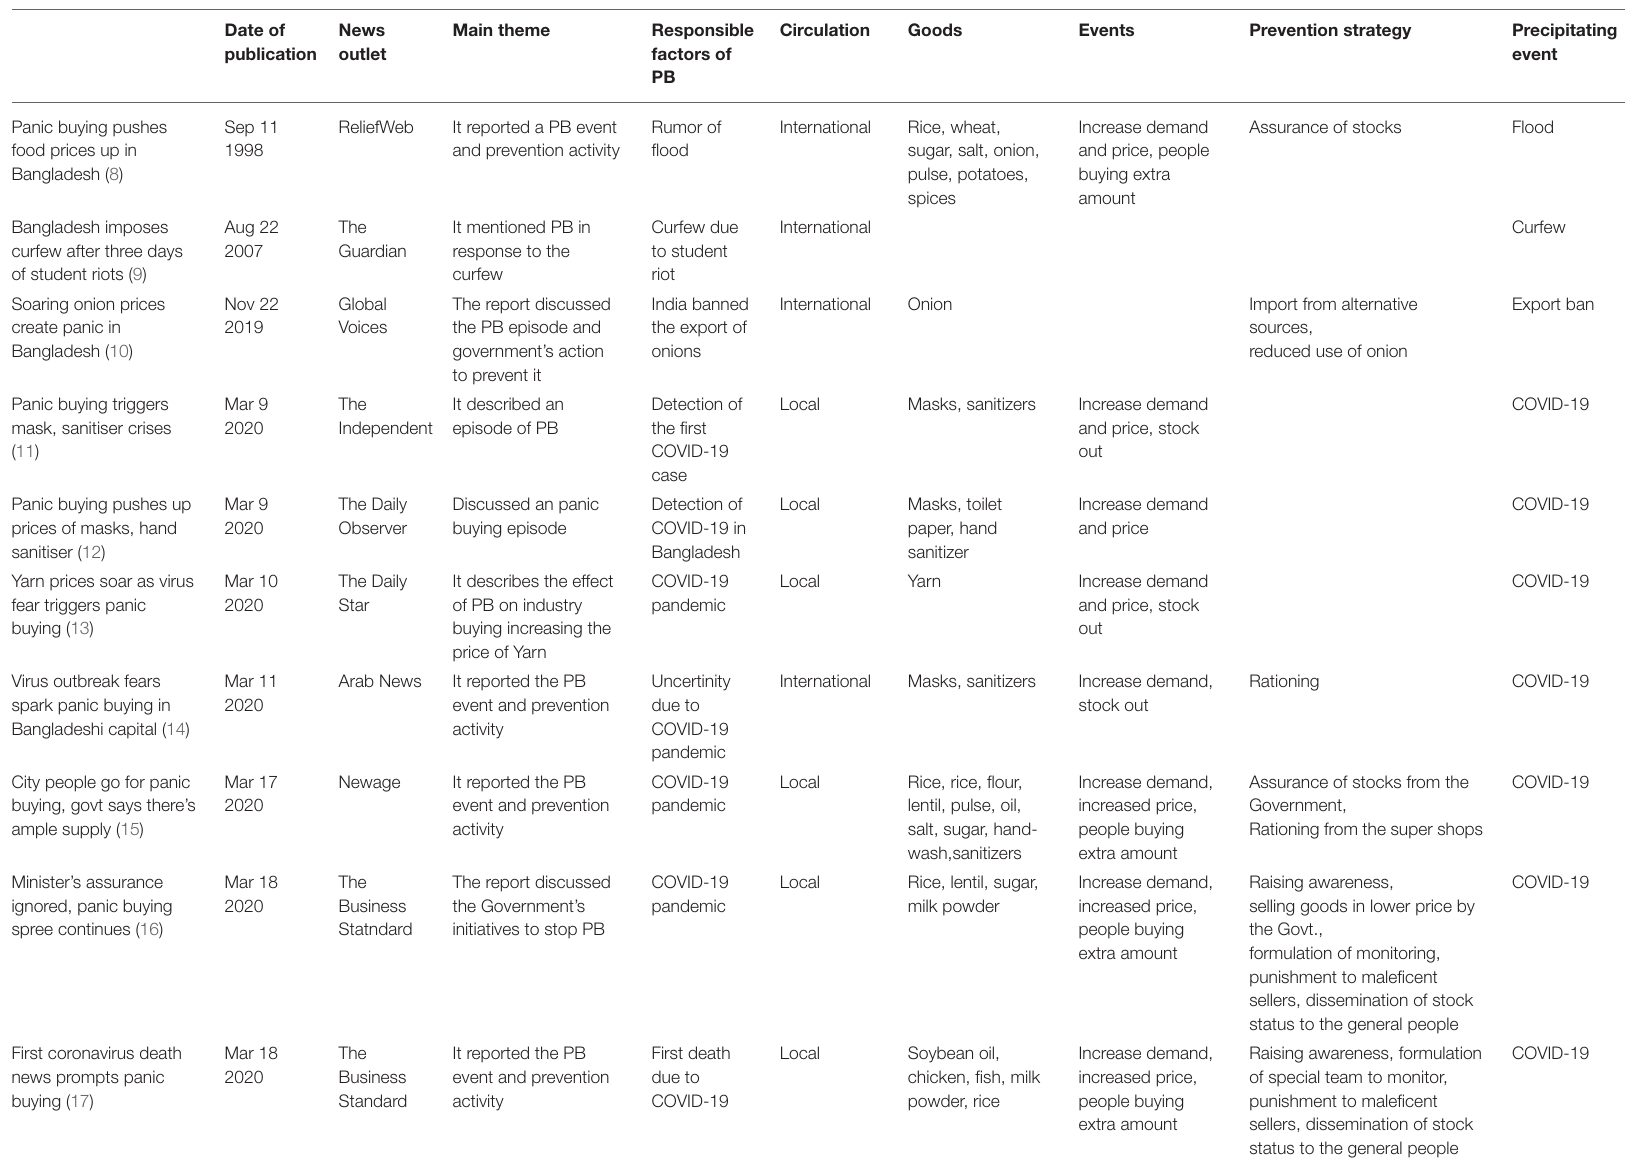
TABLE 1 | Detail contents of reports ( n =